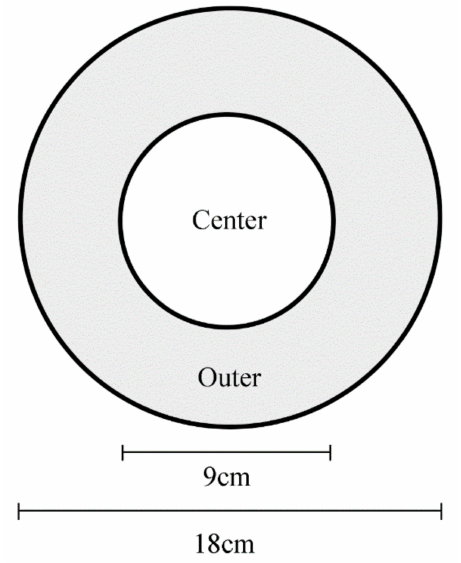
Figure 1. Top view of the open field